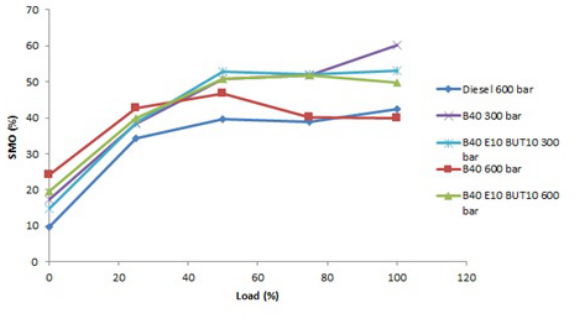
Fig. 7. Various Smoke opacity with Engine Load.